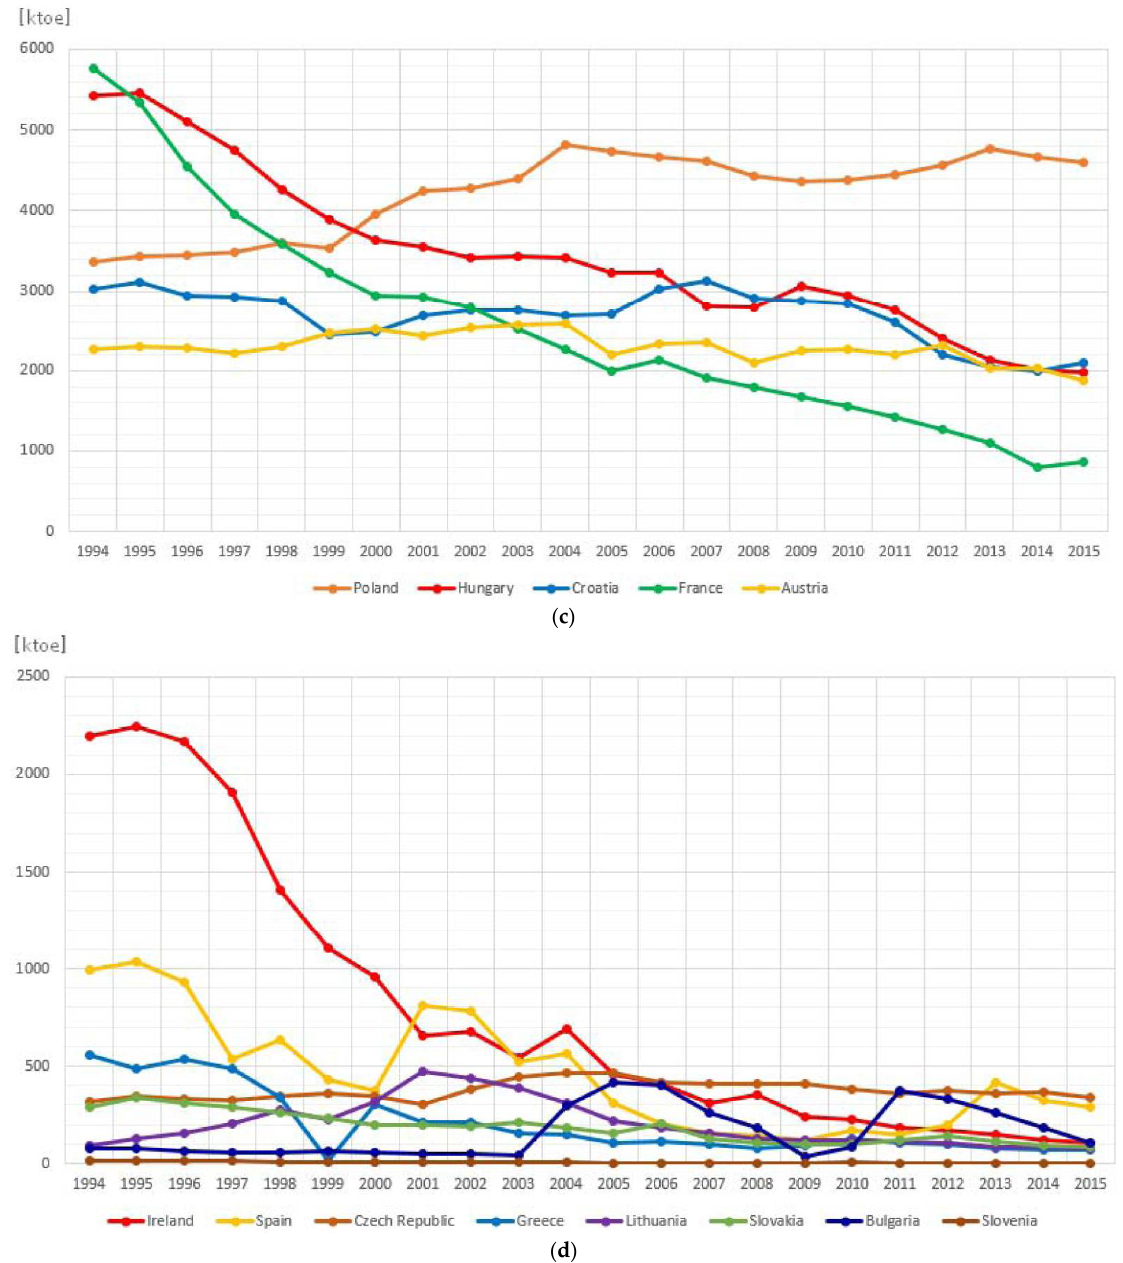
Figure 4. ( a ) Primary production (crude oil and natural gas) Class1 (≥50,000 ktoe), ( b ) Primary production (crude oil and natural gas) Class2 (8000 – 30,000 ktoe), ( c ) Primary production (crude oil and natural gas) Class3 (1000 – 6000 ktoe), ( d ) Primary production (crude oil and natural gas) Class4 (≤1000